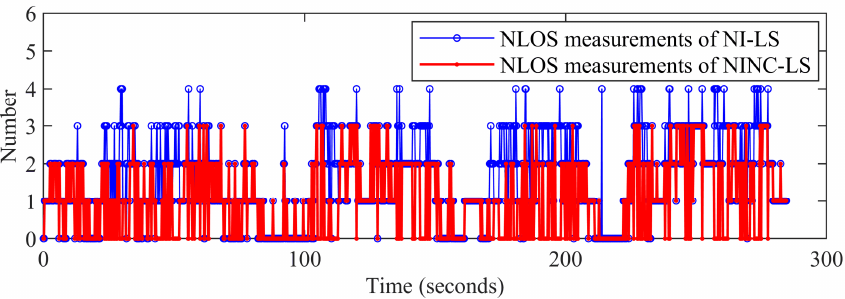
Figure 12. Number of NLOS measurements for the NI-LS (blue) and NINC-LS (red) methods.